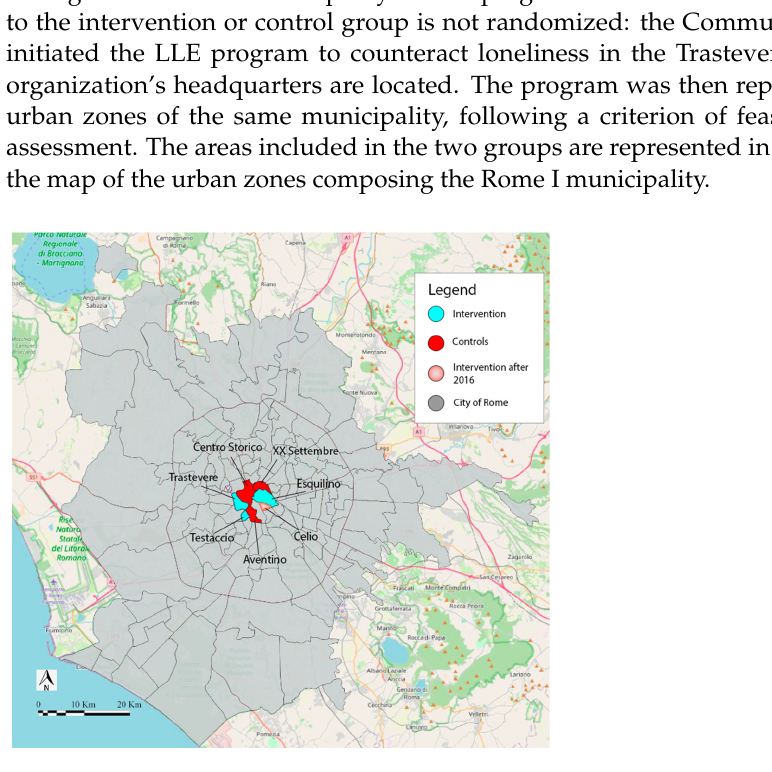
Figure 1. Map of the urban zones of the first municipality of Rome, Italy.